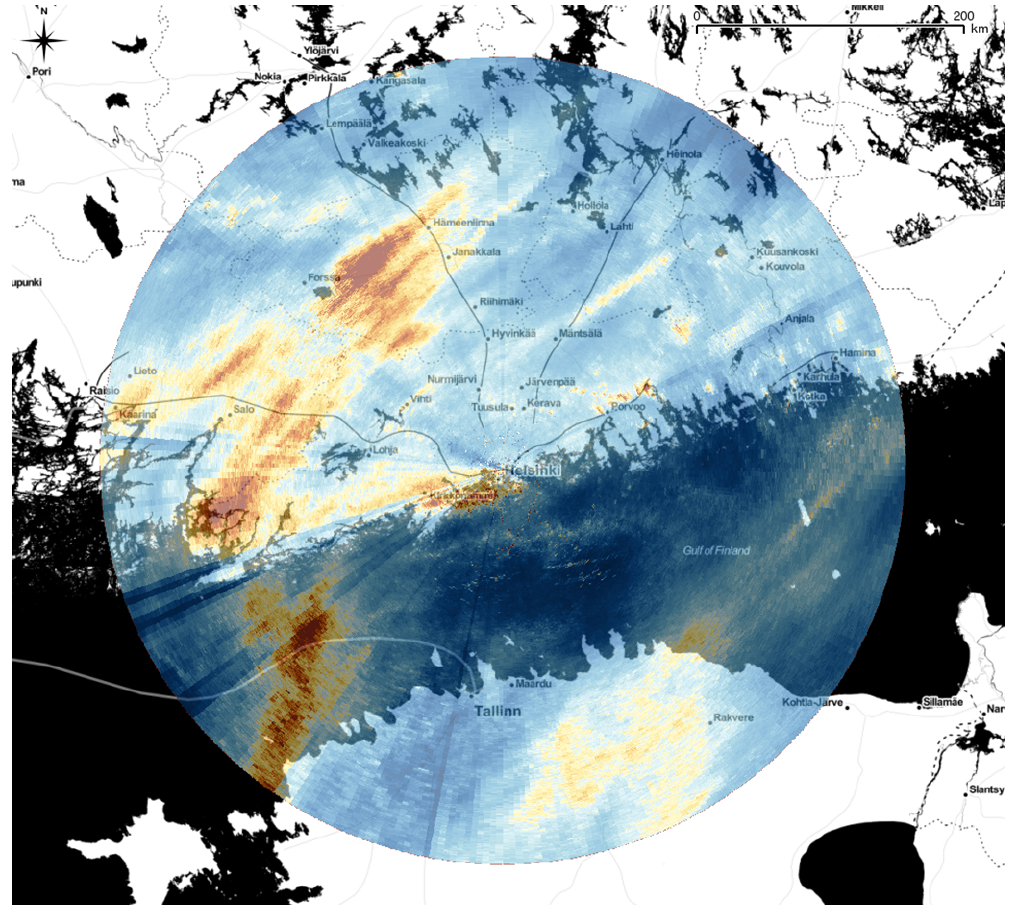
Figure 7. 24h rainfall accumulation on 22 September 2014 from Kumpula PPI reflectivity at 0.5 ◦ elevation.